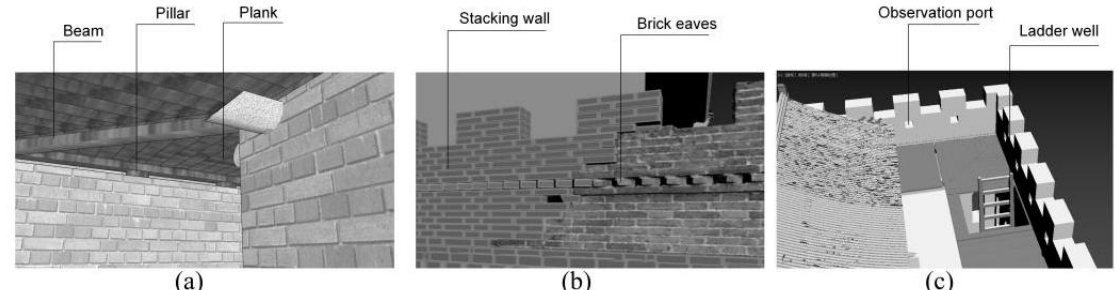
Figure 9. The details of virtual restoration:( a ) The floor structure of the brick-wood structure type; ( b ) The accessorial structures of battlemen; ( c ) The details of the second floor.